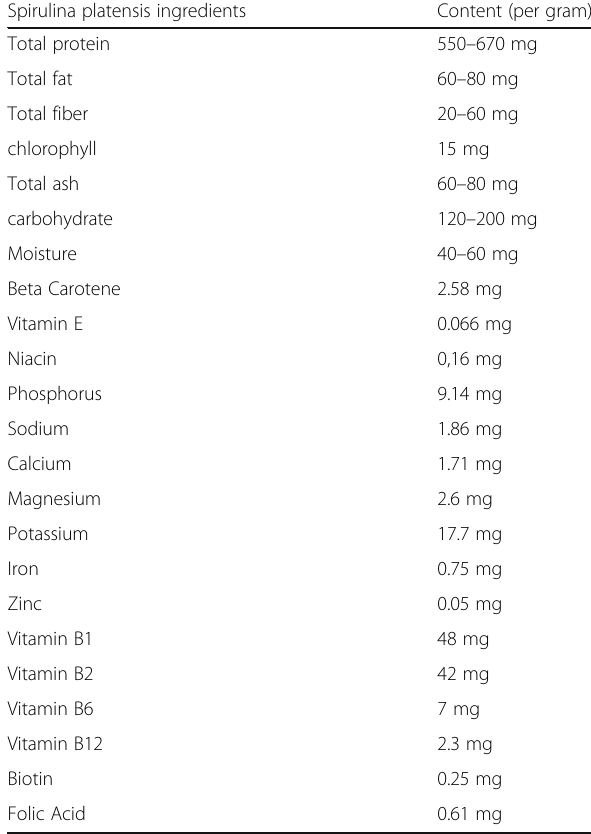
Table 1 Contents of the Spirulina platensis supplement a Spirulina platensis